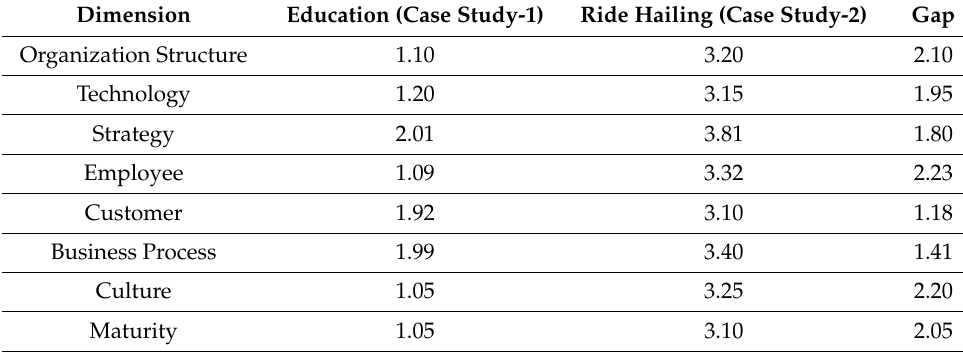
Table 6. Maturity Gaps Across Case